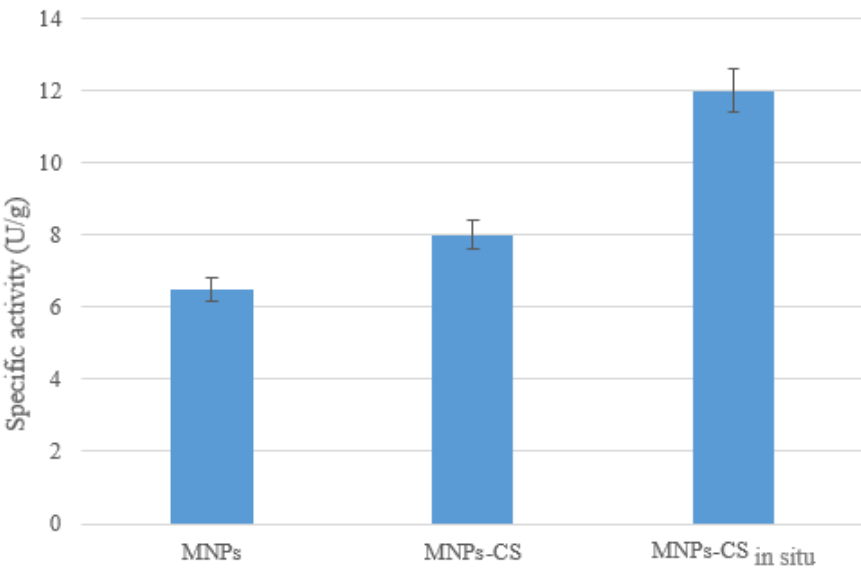
Figure 3. Specific activity of the naked MNPs, CS-coated manganese ferrites (MNPs-CS) and the one coated with CS during their formation (MNPs-CS in situ ) .